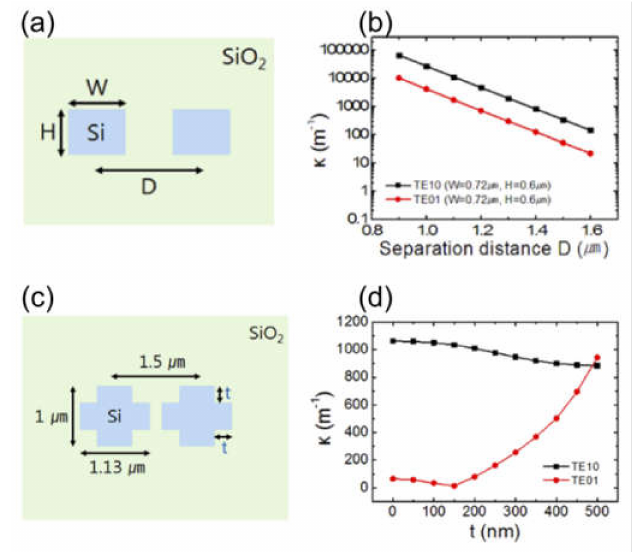
Figure 13. Cross-section of rectangular WG coupler ( a ) [164], the coupling coefficient of TE 10 and TE 01 modes in case of W = 0.72 µ m and H = 0.6 µ m ( b ) [164], the cross-section of cross shape WG coupler ( c ) [164], the coupling coefficient of TE 10 and TE 01 modes as a function of t ( d )